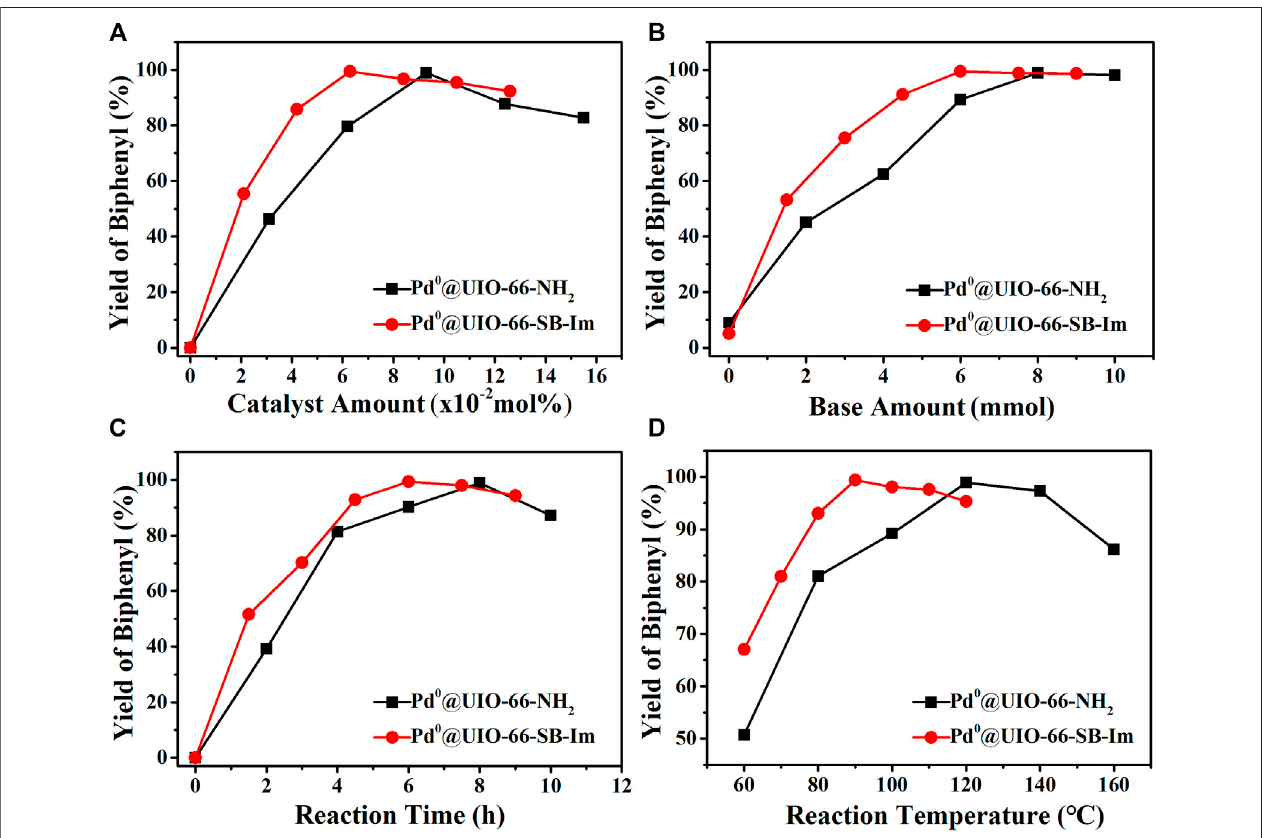
FIGURE6 | The relationship betweenthe activity and (A) catalyst amount, (B) baseamount, (C) reaction time, and (D) reaction temperature inthe Suzuki coupling reaction.Pd 0 @UIO-66 – SB – Imcatalyzedreaction conditions:Pd 0 @UIO-66 – SB-Im(0.06 mol%basedonbromobenzene),bromobenzene(2 mmol), phenylboronicacid (3 mmol),NaHCO 3 (6 mmol),DMA(5 ml),6 h,90 ° C.Foreachplot,aspeci fi cparameterischanged.Pd 0 @UIO-66 – NH 2 catalyzedreactionconditions:Pd 0 @UIO-66 – NH 2 (0.09 mol%basedonbromobenzene),bromobenzene(2 mmol),phenylboronicacid(3